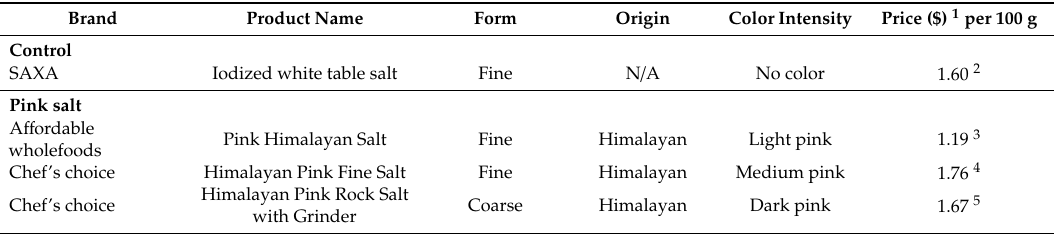
Table 1. Description of pink salt ( n = 31) and iodized white table salt ( n = 1) samples purchased from retail stores in Australia in June